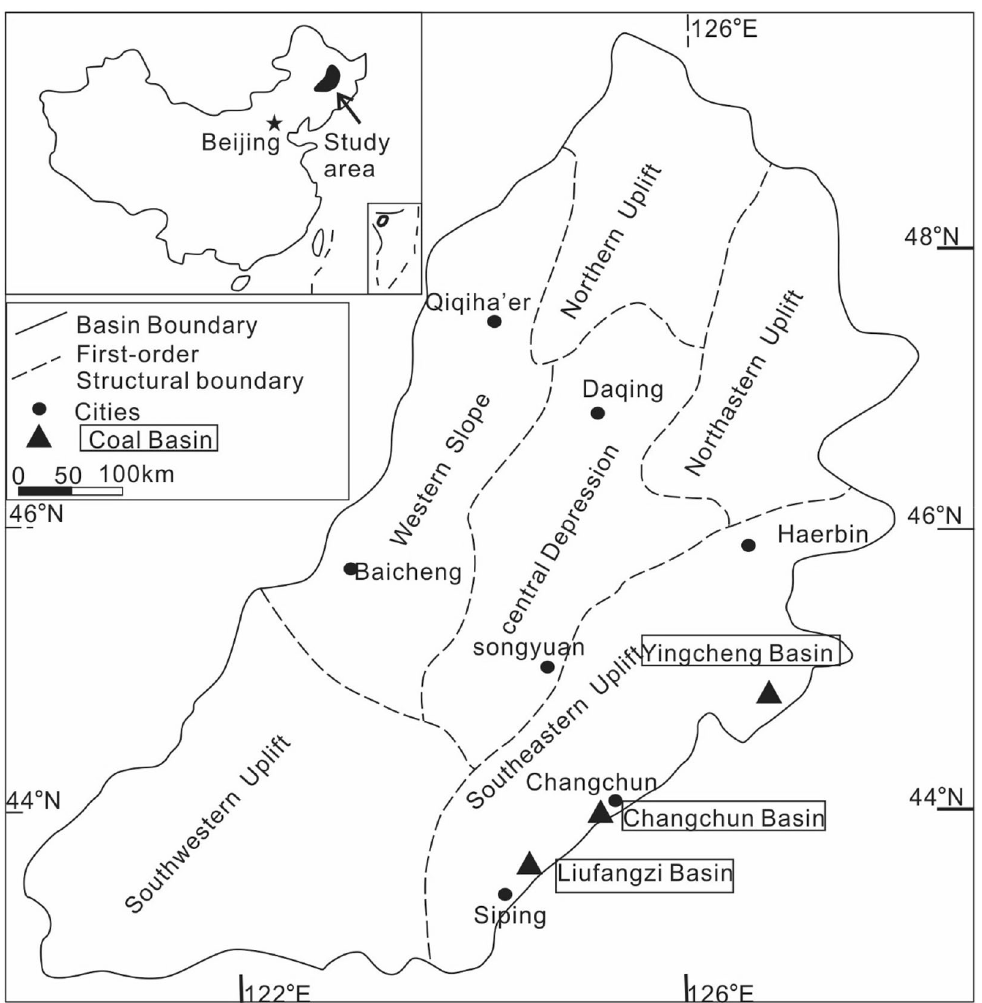
Fig. 1 Sketch map showing structural units and coal basins location of Songliao Basin ( modified according to Wang et al. 2007 and Feng et al.